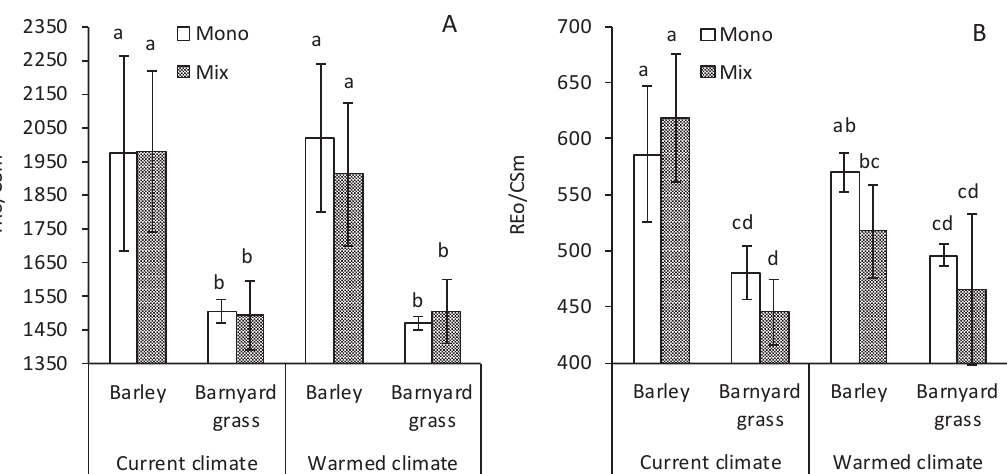
Fig. S 2. The changes of trapped energy flux (TRo/CSm) (A) and reduction of end acceptors at PSI electron acceptor side (REo/CSm) (B) in barley ( Hordeum vulgare L.) and barnyard grass ( Echinochloa crus-galli L.) plant leaves grown in mono culture (Mono; 15 plants per pot) and mix culture (Mix; 9 crop plants and 6 weeds) under the current climate (400 µmol mol -1 CO ; day/night temperatures 21/14 °C) and the warmed climate (800 µmol mol -1 CO 2 °C) conditions. Each value represents the mean ±CI (n=3). Different letters indicate significant differences at p <0.05 between the treatments as determined by Least Significant Differences (LSD)